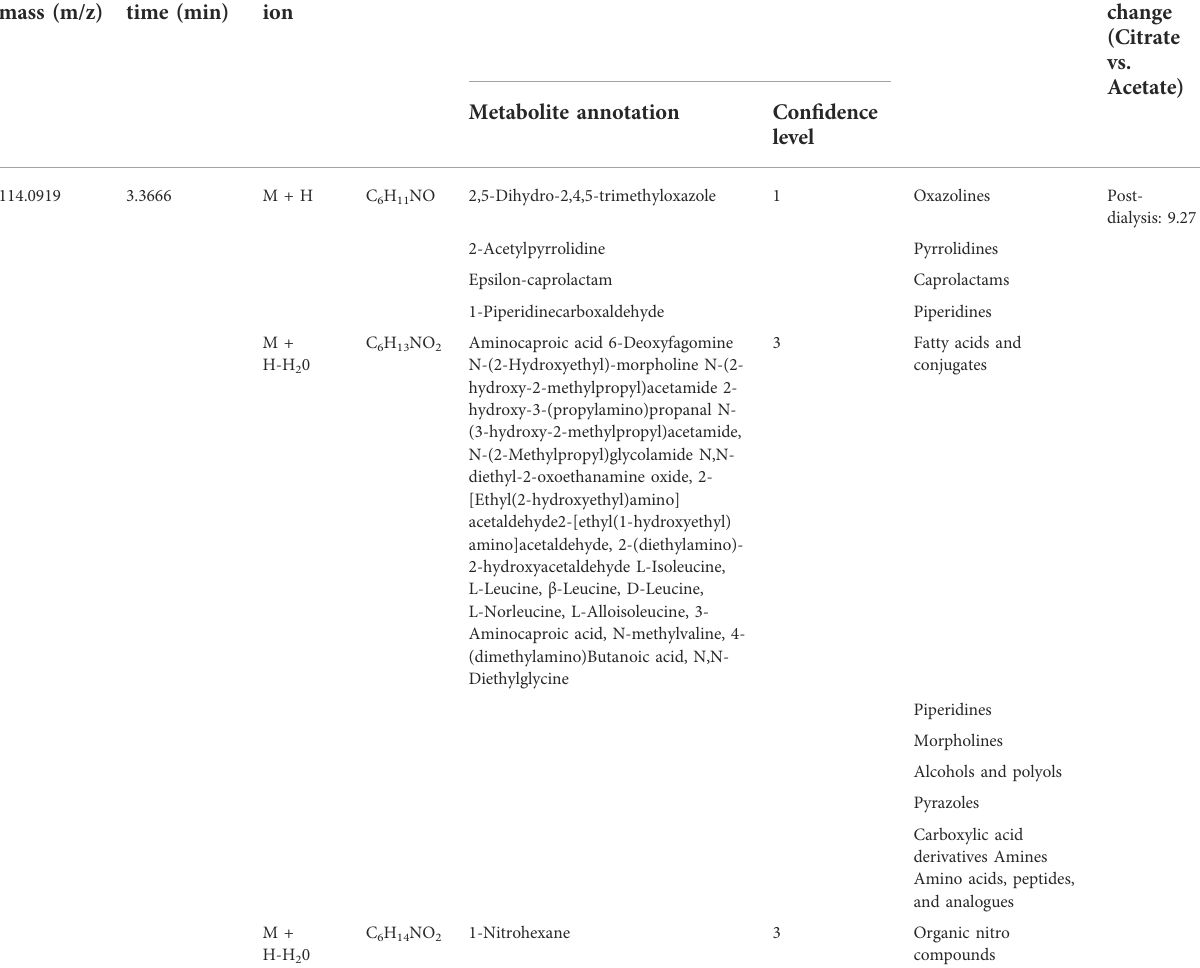
TABLE 5 Identi fi cation of the most discriminant metabolomic variables between AD and CD in post-dialysis and rebound measurements. Accurate Retention mass (m/z) time